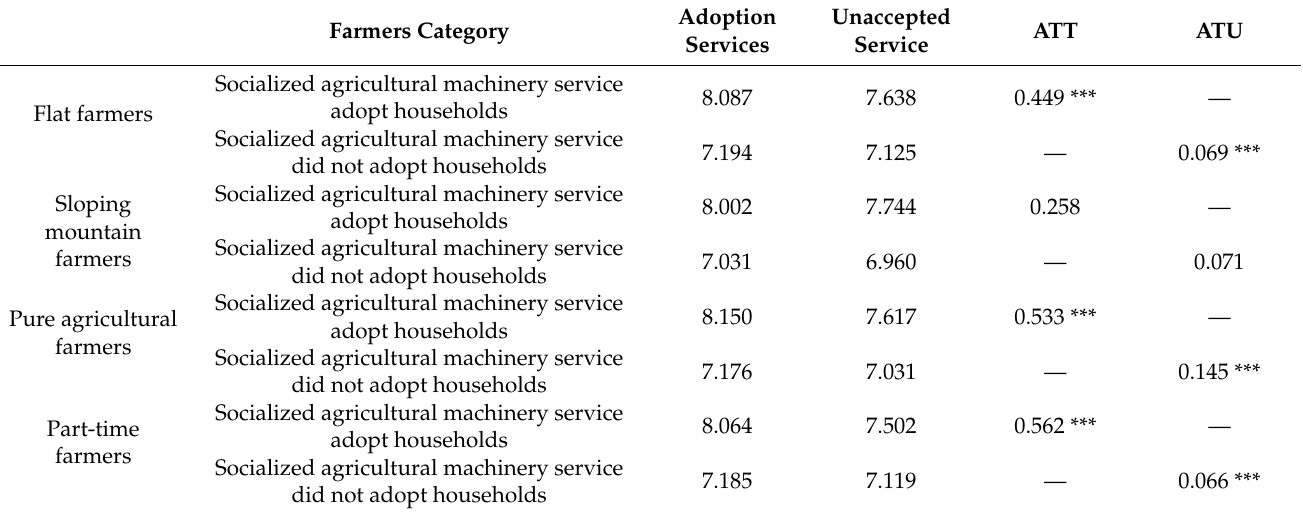
Table 7. The impact of socialized agricultural machinery service on land productivity based on the heterogeneity of terrain and part-time